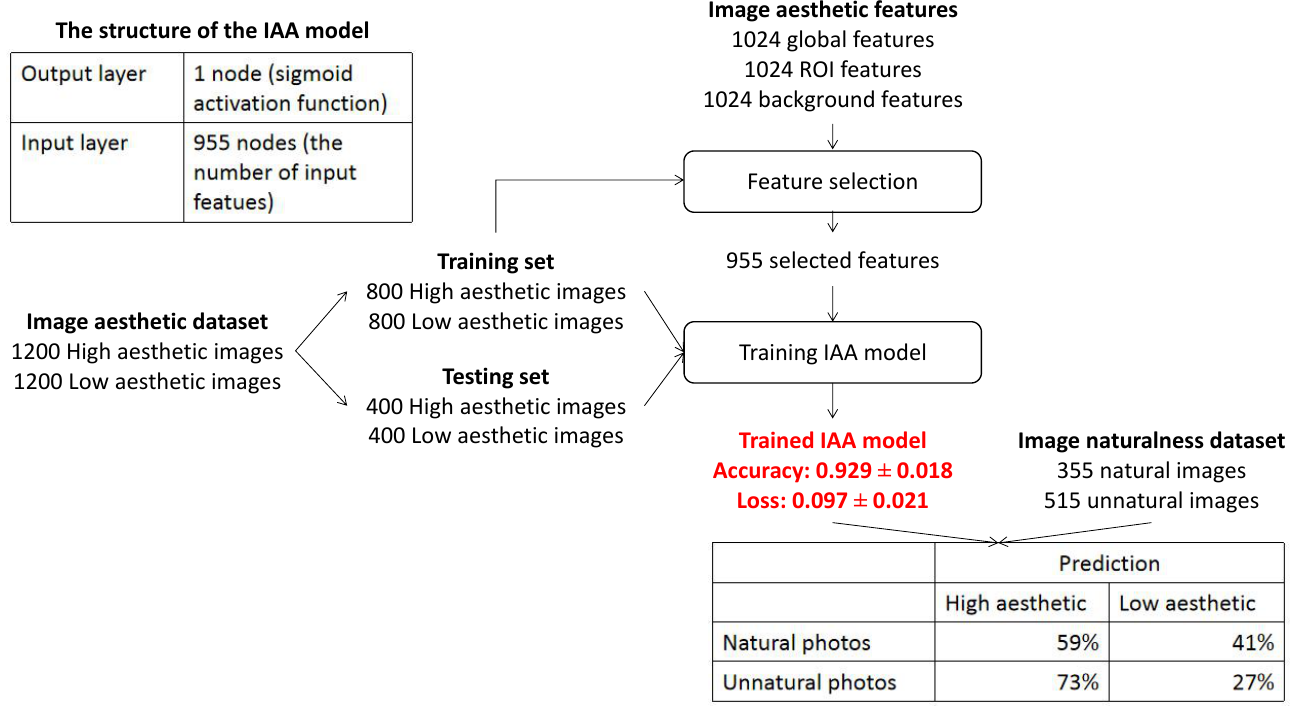
Figure 8. Process of the experiment evaluating the IA of the IN dataset